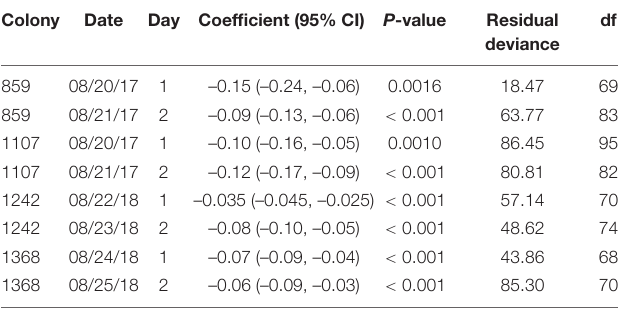
TABLE 3 | The slope coefficients of Poisson regression of total trip number per ant on relative humidity are significantly negative (95% confidence intervals provided in parentheses).